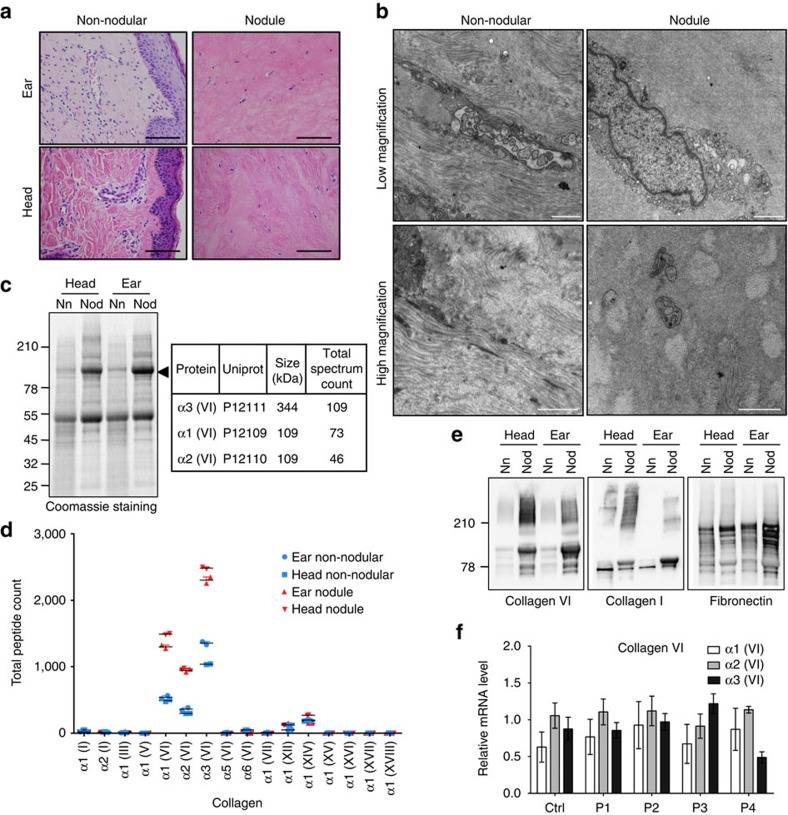
HFS patient nodules display ECM accumulation and loss of skin adnexa and dermal vessels.(a) H&E staining of formalin-fixed non-nodular skin and nodule from the ear and the head of a HFS patient. The nodule displays a striking accumulation of ECM, causing secondary loss of skin adnexa, vascular structures and rarefaction of the dermal cellular component. One biopsy was obtained by tissue. A representative image is shown for each. Scale bar, 200 μm. (b) Ultrastructure by EM of non-nodular and nodular tissues of a HFS patient. Representative images of non-nodular or nodule tissues at low magnification (upper panel) and higher magnification (lower panel) are shown. At least two grid per tissue biopsies were prepared. Scale bar, 1 μm. (c,e) Comparison of non-nodular (Nn) and nodule (Nod) tissues from the ear and the head of a HFS patient. Tissue lysates were analysed by SDS–PAGE using 4–12% Bis-Tris gradient gels under reducing condition followed either by staining with Coomassie blue (c) or by western blot for collagen VI, collagen I or fibronectin (e). The prominent 100 kDa band (arrowhead) was excised, trypsin digested and its composition analysed by nano LC-MS/MS. Only the three collagen VI alpha chains were detected with >2 peptides. Migration of the molecular weight markers (in kDa) is indicated on the left. See Supplementary Fig. 7a for the uncropped version of the western blots. (d) Comparison of the complete tissue lysates from head and ear non-nodular and nodule analysed by nano LC-MS. The total number of peptides associated with each collagen protein is indicated. Each lysate was run twice in the nano-LC-MS to account for technical variability and both peptide counts are indicated. (f) Quantitative RT–PCR analysis of mRNAs coding for the α1, α2 and α3 chains of collagen VI in fibroblast cultures from unaffected control and four HFS patients (P1–P4) (error bars represent s.e.m.; n=3).